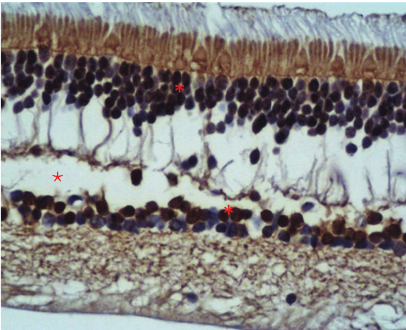
Figure 5: Histological section of healthy adult human retina. The different retinal layers appear marked in dark-marron with rabbit anti-Otx2 polyclonal antibody. Positivity is shown (from top to bottom) in photoreceptors, horizontal, bipolar, and neuronal cells (asterisks). An artifact (empty space) is present due to fixating procedure